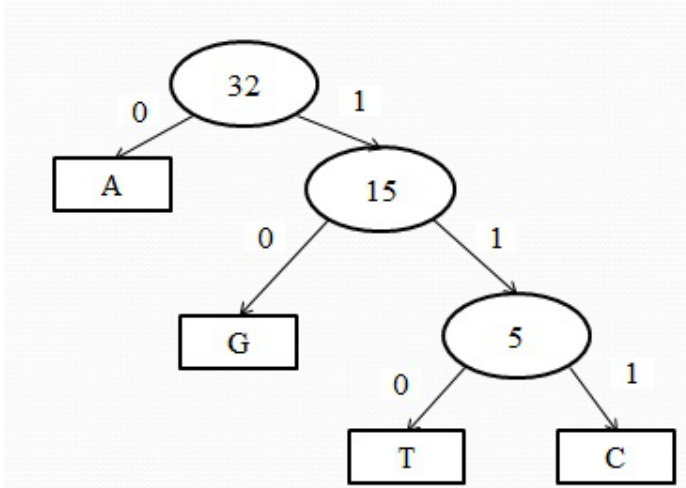
Figure 3: Generated tree for Example